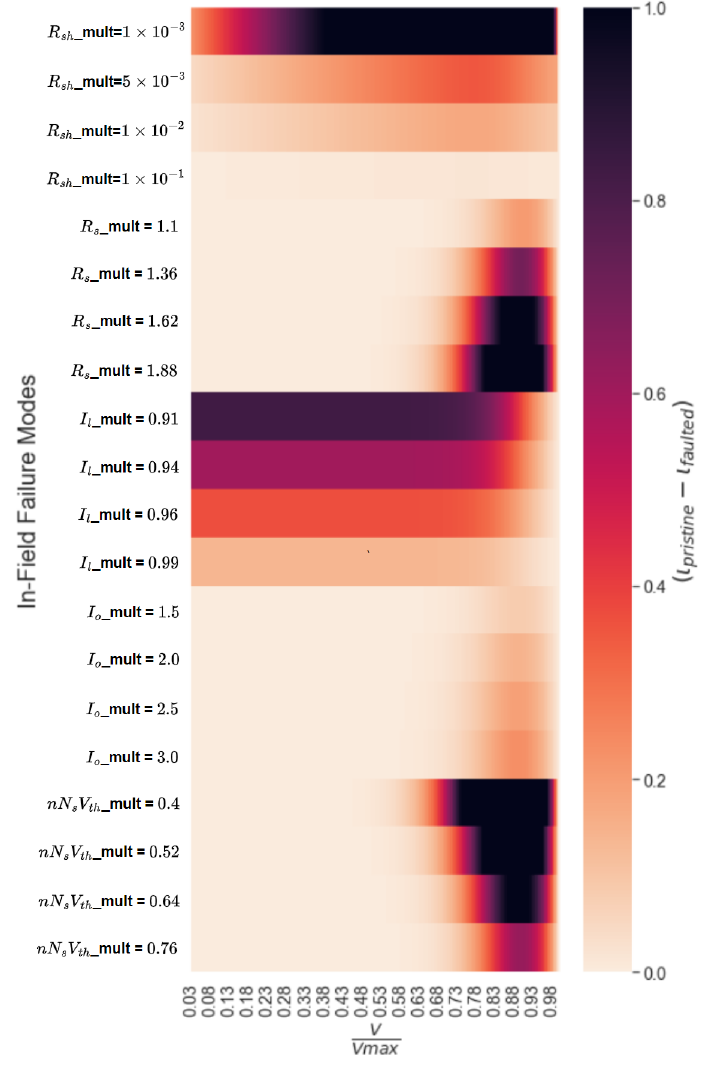
Figure 5. The flexibility of the IV simulation is displayed in a heatmap showing the different IV profiles across a spectrum of failure definitions. The test’s names on the vertical axis represent the magnitude of the impact on the diode parameter. The horizontal axis contains the normalized voltage domain. The color bar contains the difference between a pristine IV curve’s current and the failure IV curve’s